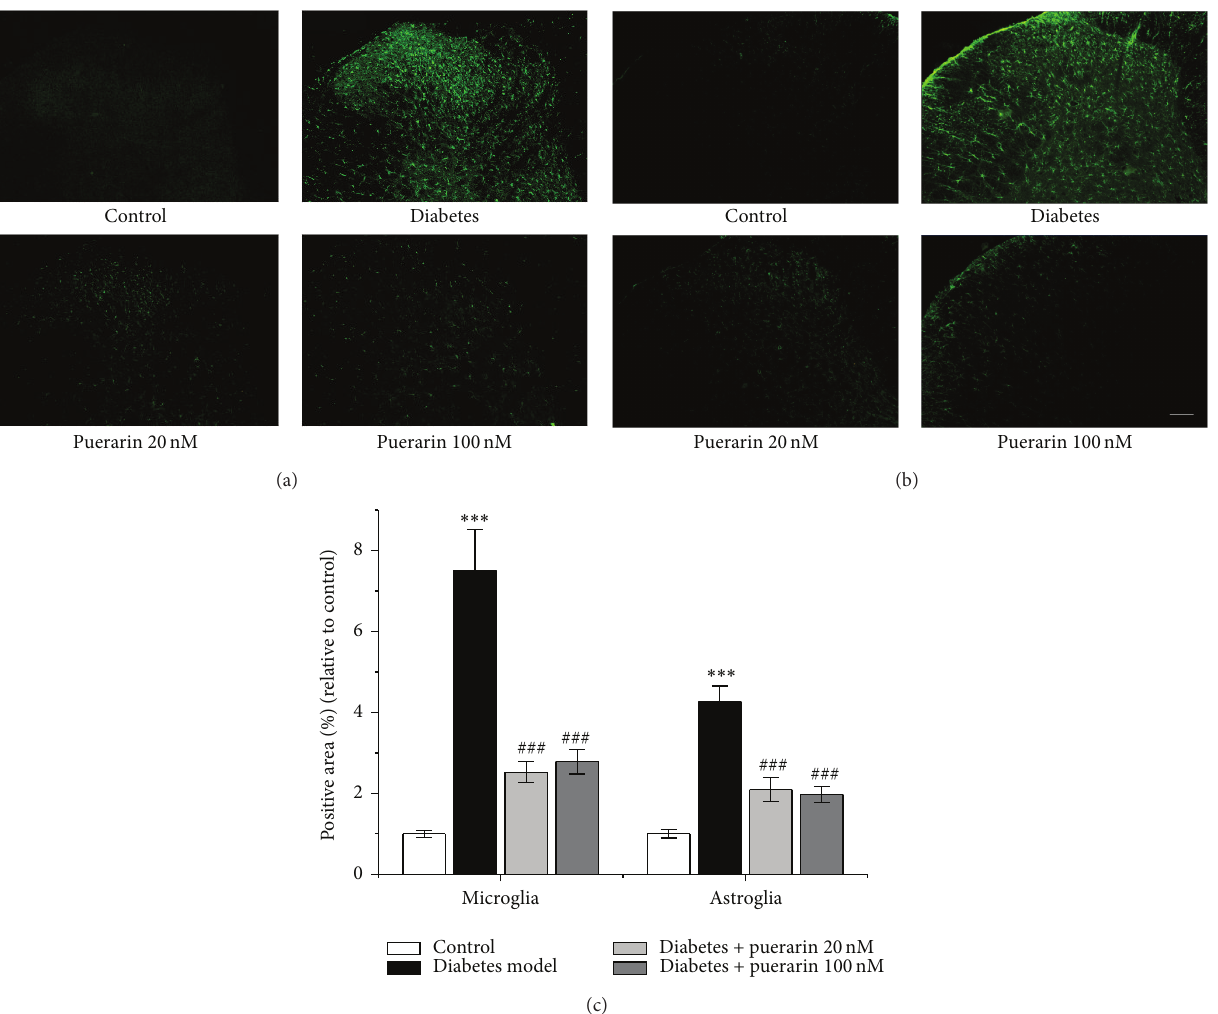
Figure 4: The effects of puerarin on diabetes-induced microglia and astroglia activation in ipsilateral spinal dorsal horn of rats. (a) and (b) Representative images of ipsilateral spinal dorsal microglia (a) and astroglia (b) activation in control rats, diabetic rats receiving vehicle, 20 and 100 nM puerarin on the 27th day after streptozotocin injection. Scale bar: 100 𝜇 m. (c) Quantification of microglia and astroglia activation in the spinal cord on the 27th day after streptozotocin injection. Data are presented as mean ± SEM. ∗∗∗ 𝑃 < 0.001 , diabetic rats versus control; ### 𝑃 < 0.001 , puerarin versus diabetes model (one-way ANOVA with post hoc LSD 𝑡 -test). Each group consisted of 6–10